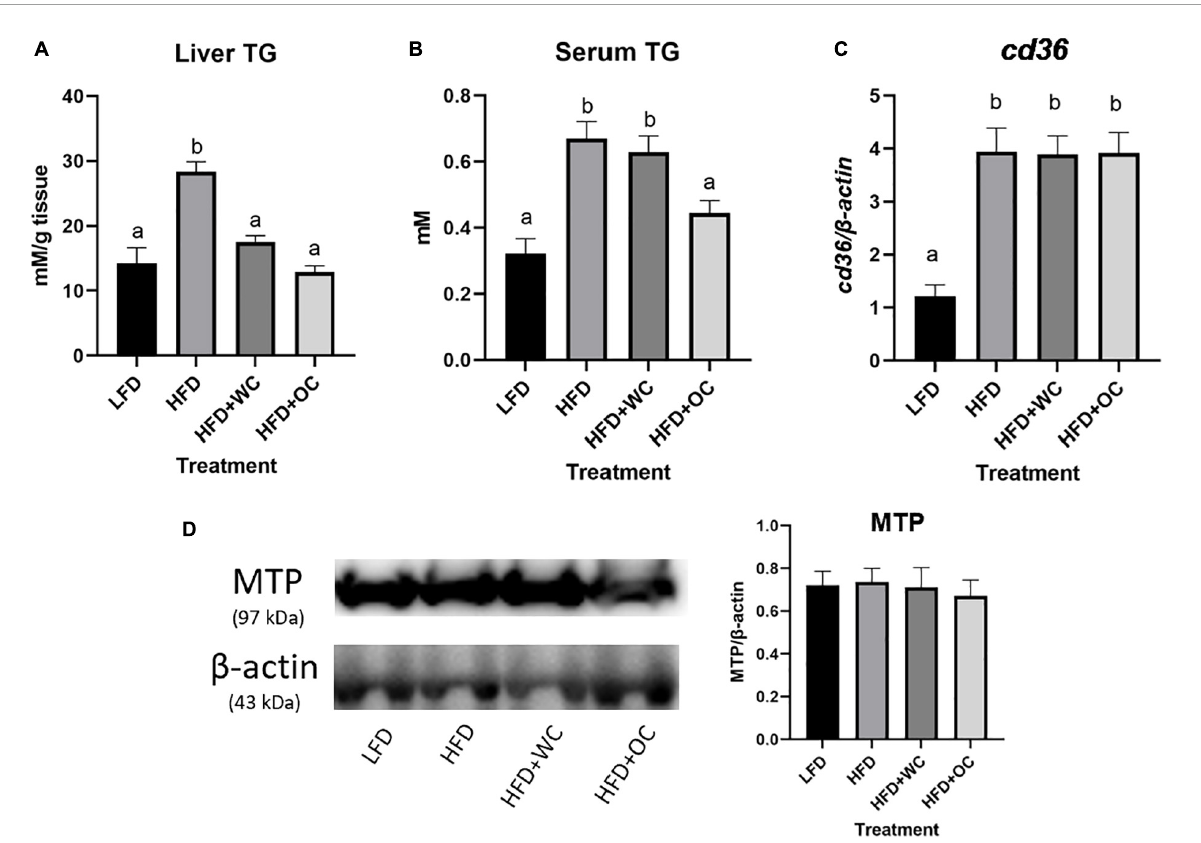
FIGURE3 Hepatic and circulatory fat content. (A,B) Triglyceride (TG) content in panel (A) liver and (B) serum. For both liver and serum TG assay, LFD, HFD, HFD + WC, HFD + OC: n = 10. (C) Changes in mRNA levels in hepatic cd36 generated from qPCR. (D) Western blot of hepatic MTP protein expression performed with 3–8% tris-acetate gel, graphical changes between the dietary groups. For both western blot and qPCR assays, LFD: n = 11; HFD, HFD + WC, HFD + OC: n = 12. Values are means ± SEM. Data were analyzed by one-way ANOVA with post hoc Tukey HSD. Letter differences indicate statistical significance ( p < 0.05).